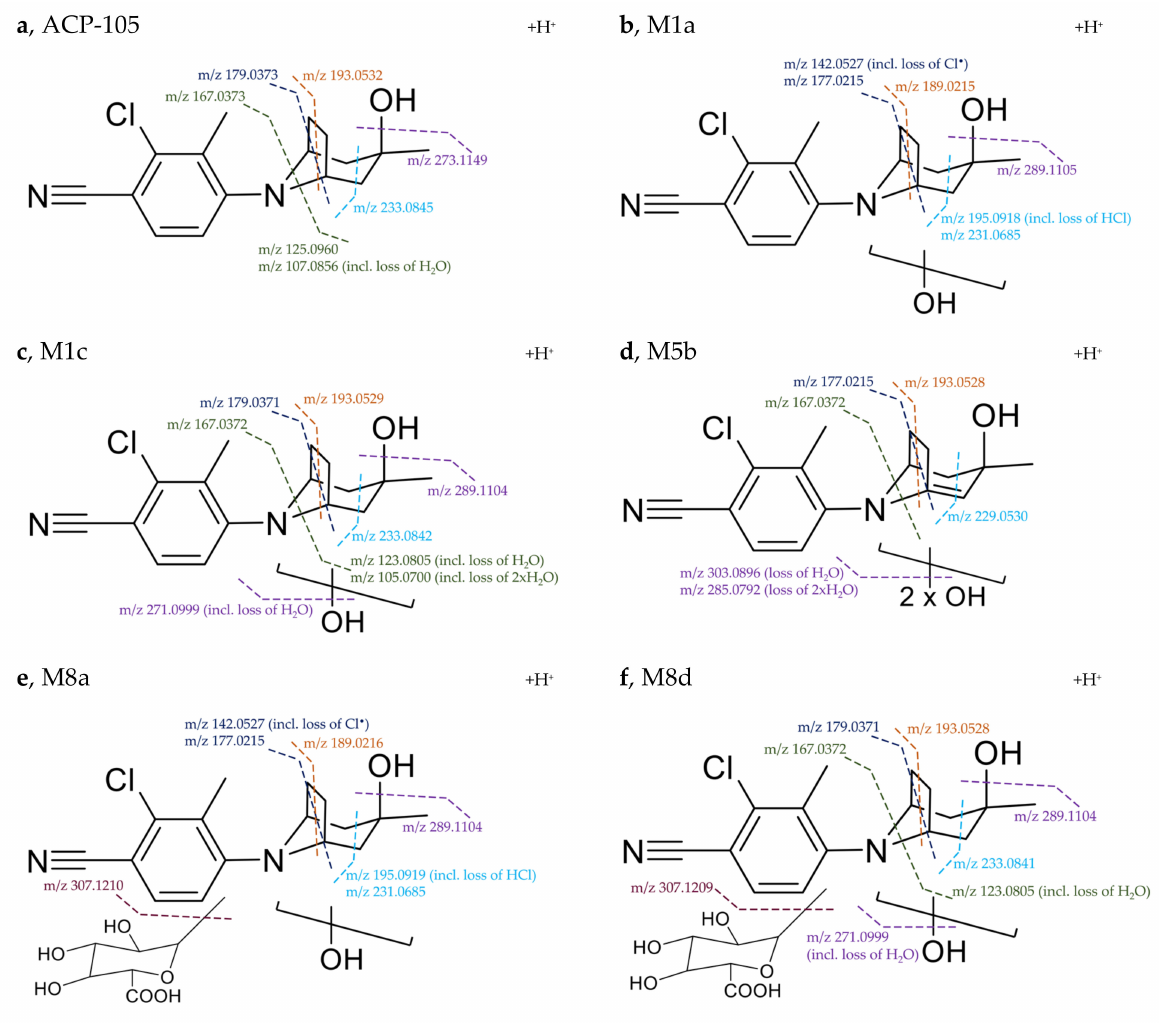
Figure 5. Suggested fragmentation pattern of the major metabolites in comparison with ACP-105. ( a ) Parent ACP-105— precursor ion [C 16 H 20 ClN 2 O] + at m / z 291.1262; ( b ) monohydroxylated metabolite M1a—precursor ion [C 16 H 20 ClN 2 O 2 ] + at m / z 307.1209; ( c ) monohydroxylated metabolite M1c—precursor ion [C 16 H 20 ClN 2 O 2 ] + at m / z 307.1209; ( d ) dihydrox- ylated metabolite with formed double bond M5b—precursor ion [C 16 H 18 ClN 2 O 3 ] + at m / z 321.1003. The exact position of the formed double bond within the aliphatic ring structure is not known, but it will change the previous chair for- mation; ( e ) monohydroxylated and glucuronidated metabolite M8a—precursor ion [C 22 H 28 ClN 2 O 8 ] + at m / z 483.1532; ( f ) monohydroxylated and glucuronidated metabolite M8d—precursor ion [C 22 H 28 ClN 2 O 8 ] + at m / z